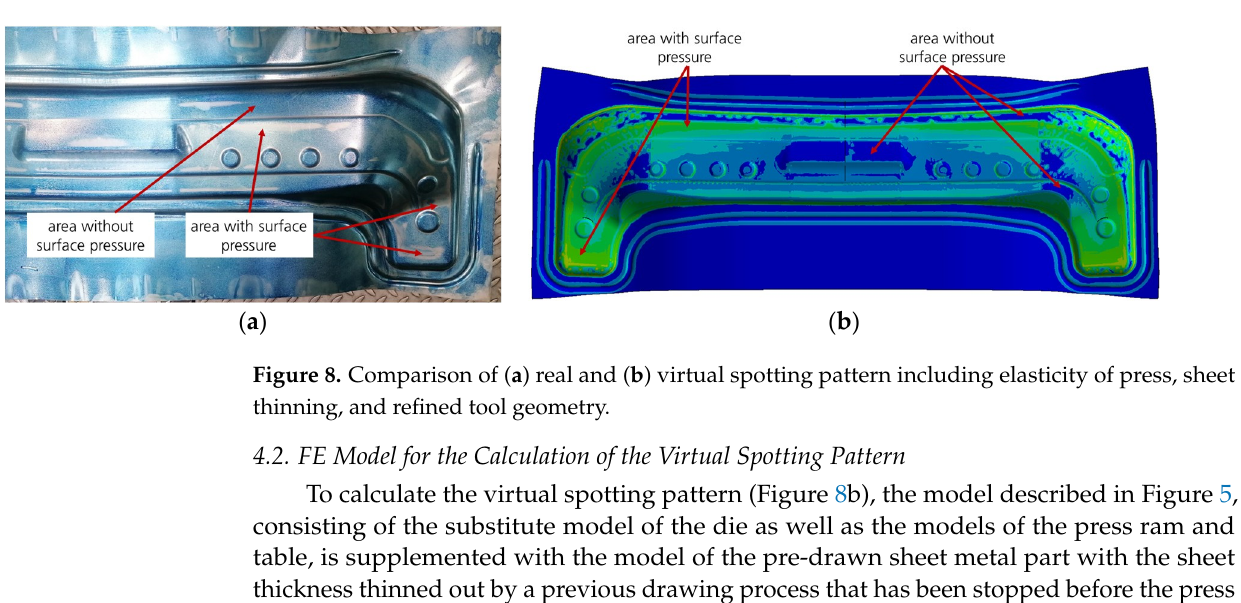
Figure 10. Virtual spotting pattern with 6 MN press force, ideal die geometry, infinite stiffness of the table and ram clamping surface, without sheet thinning ( left ) and with sheet thinning ( right ). ( b ) Figure 11. ( a ) Real first spotting pattern before mechanical reworking and ( b ) in simulation with unoptimized tool geometry including machine elasticity and sheet thinning at 6 MN press force. Even though the elasticity of the sheet is of subordinated relevance in the calibration process, the thinning due to the preceding drawing process has a large influence on the pressure distribution. Figure 10 (right) shows the spotting pattern resulting from the same simulation, including the varying sheet thickness of the previously drawn workpiece, which results in areas with lower pressure and, consequently, local pressure hotspots, es- pecially in the areas of smaller radii (domes).